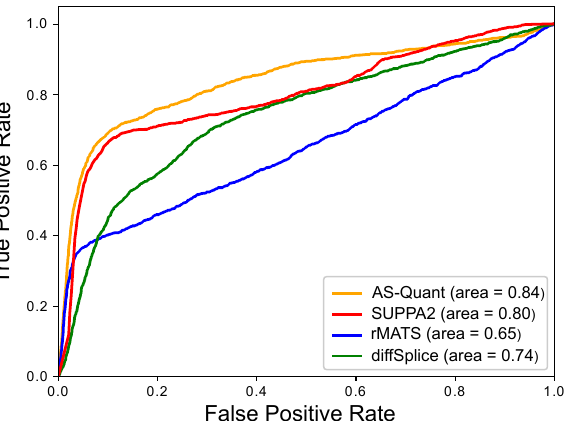
Figure 2. Simulation experiment to assess the performance of AS-Quant and baseline methods. The receiver operating characteristic (ROC) curves, i.e., true positive rate against false positive rate, are plotted. Table 2. Comparison among AS-Quant, SUPPA2, rMATS, and diffSplice on simulated RNA-seq data. AUC score, sensitivity, specificity of the four methods on five different types of splicing events are reported. The best results across the four methods are